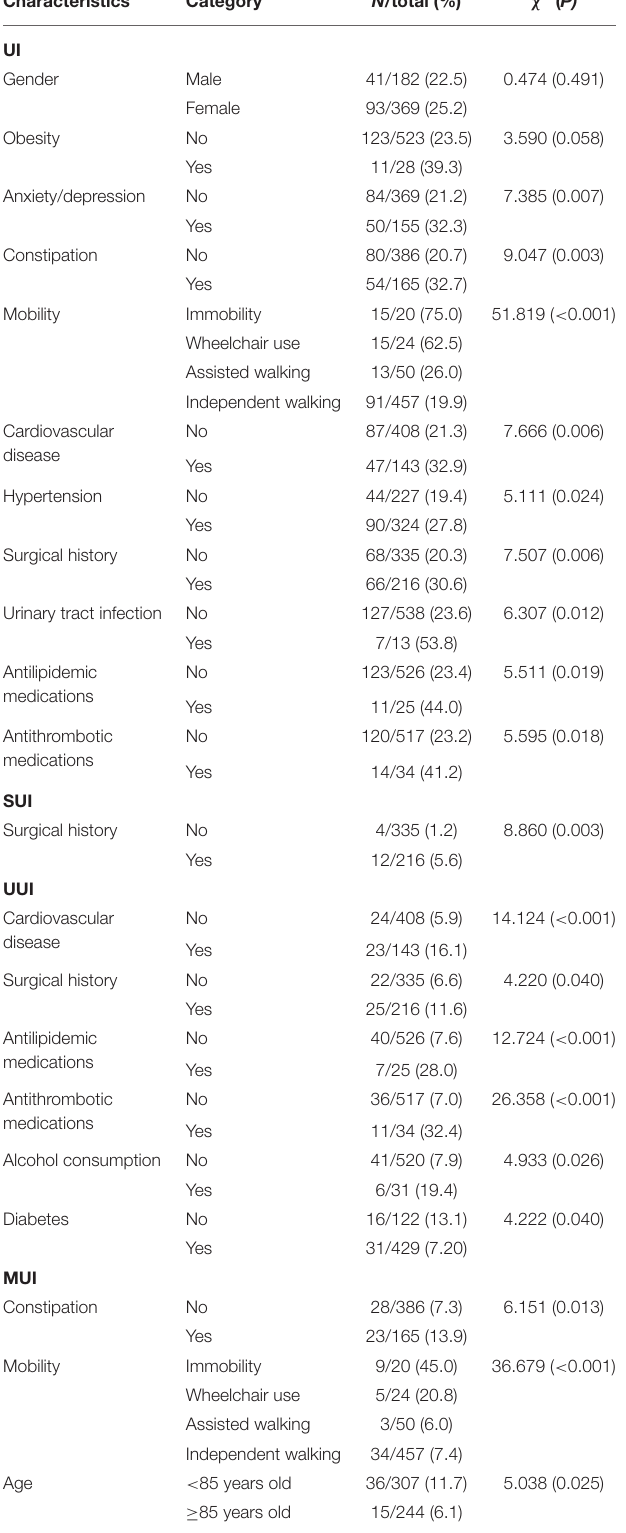
TABLE 3 | Prevalence rate of UI in different character of nursing homes ( n = 551).